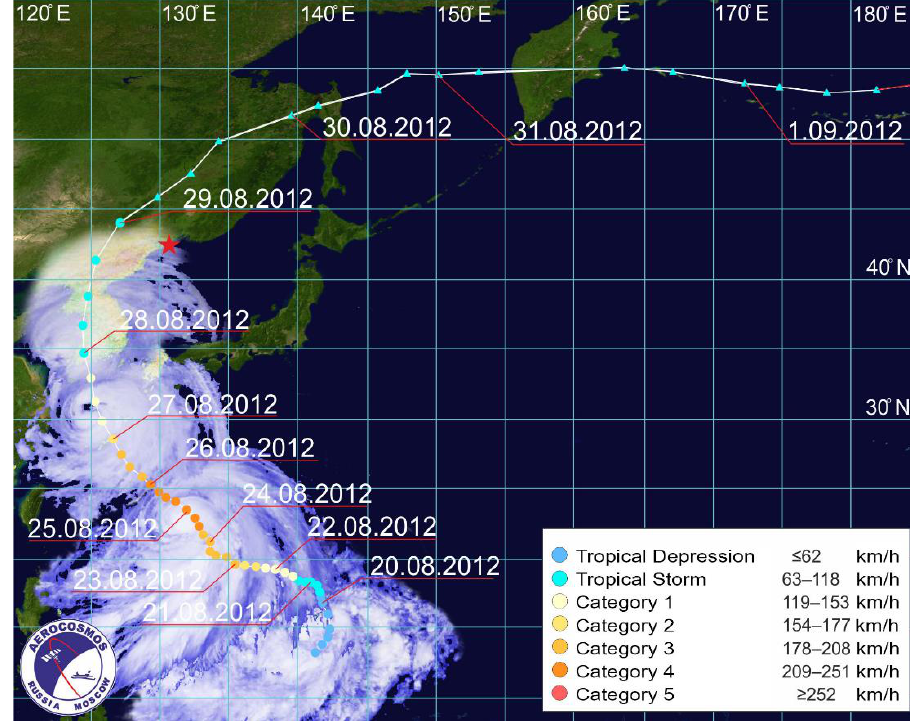
Figure 5. Typhoon Bolaven trajectory aligned with the images made by the “Himawari-7” satellite in the infrared range. Red star – location of laser strainmeters.